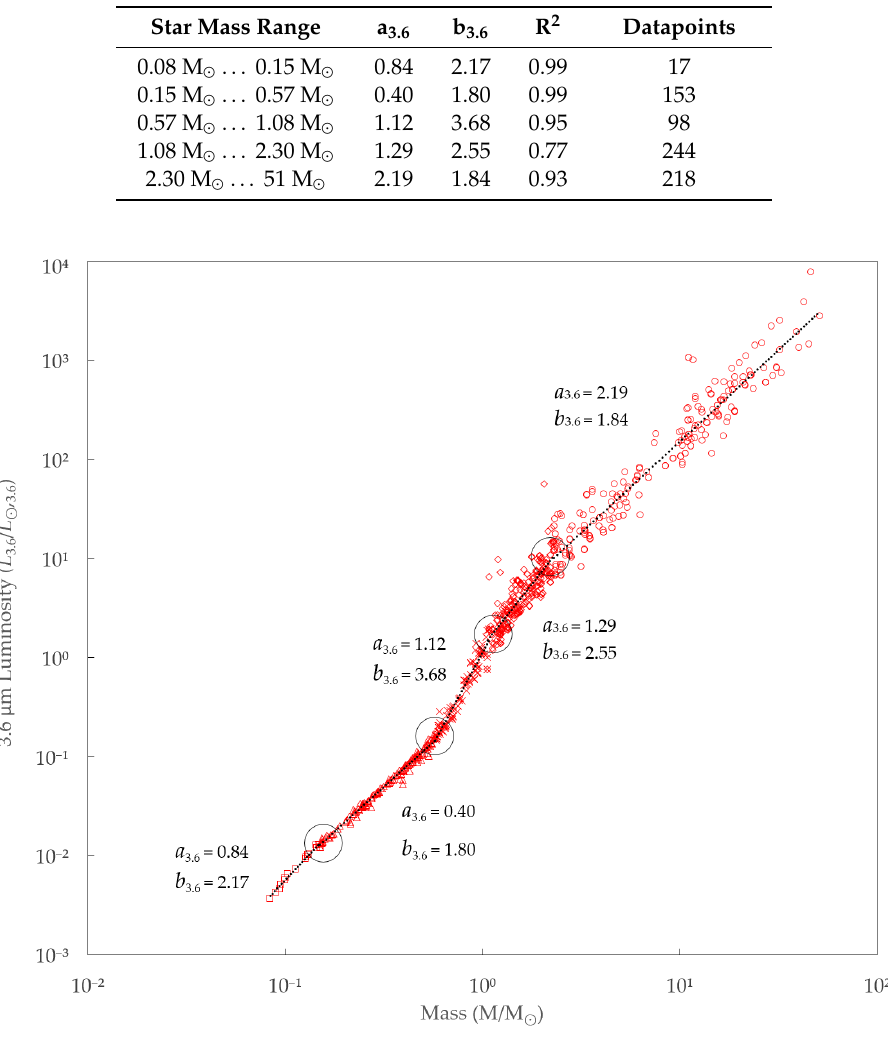
Figure A2. Main Sequence stellar mass–luminosity relation in Spitzer 3.6 µ m passband. Based on a sample composed of 4 calibrating data sets: Eker et al. (2015), Malkov (2007), Mann et al. (2015), and Vitrichenko et al.